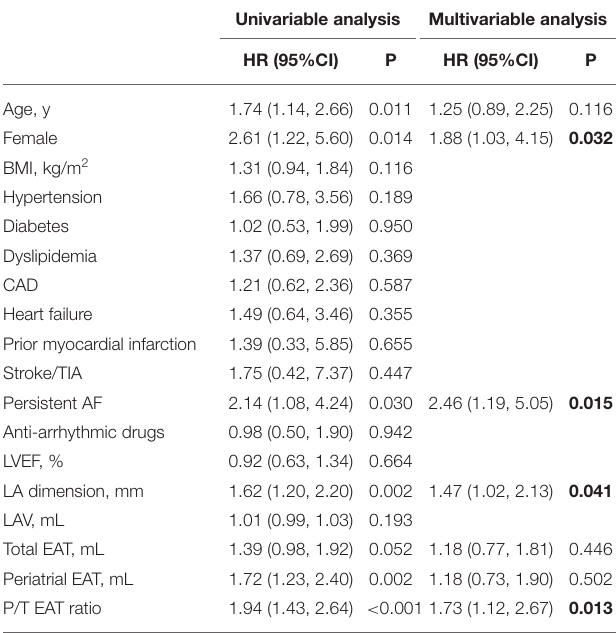
TABLE 3 | Univariable and multivariable cox regression analysis for atrial fibrillation recurrence post-ablation. Univariable analysis Multivariable